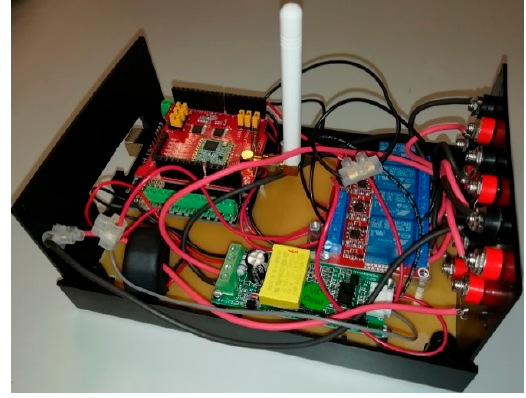
Figure 2. IMEMSL without GPS version.